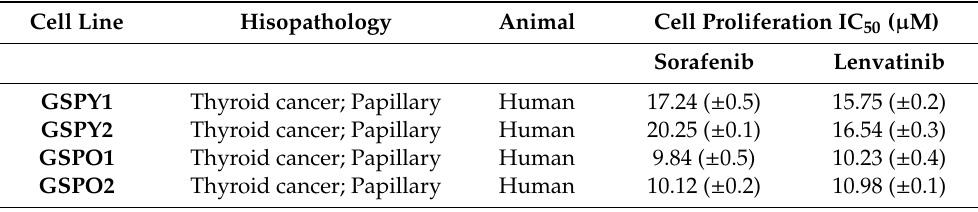
Table 3. IC 50 based on cell proliferation assay. Each data point represents the mean of 3 independent MTT assays; IC 50 was determined in triplicate. SD, standard deviation.